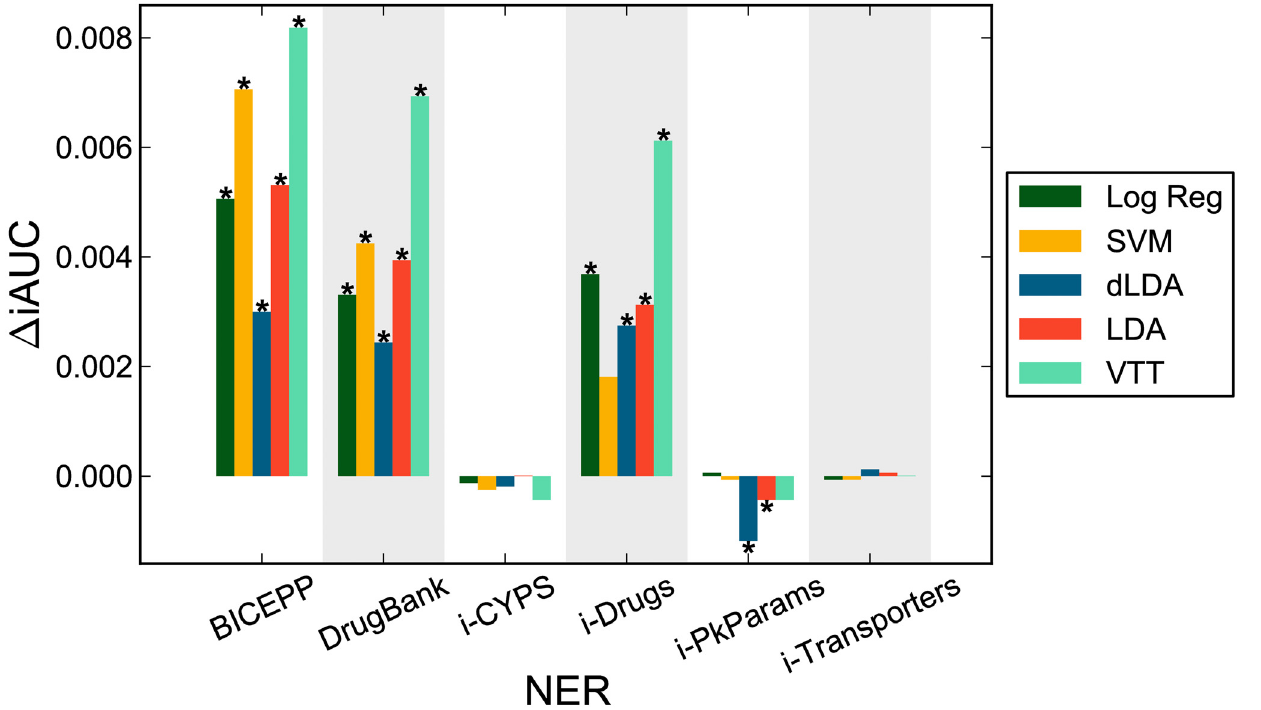
Fig 5. Performance impact of sentence NER features. Relative changes in iAUC scores on sentence bigram runs (without transforms or dimensionality reductions) in combination with different NER features. Significant changes ( p < 0.05, two-tailed test) in performance over respective classifiers without NER features are indicated with asterisk ‘ * ’